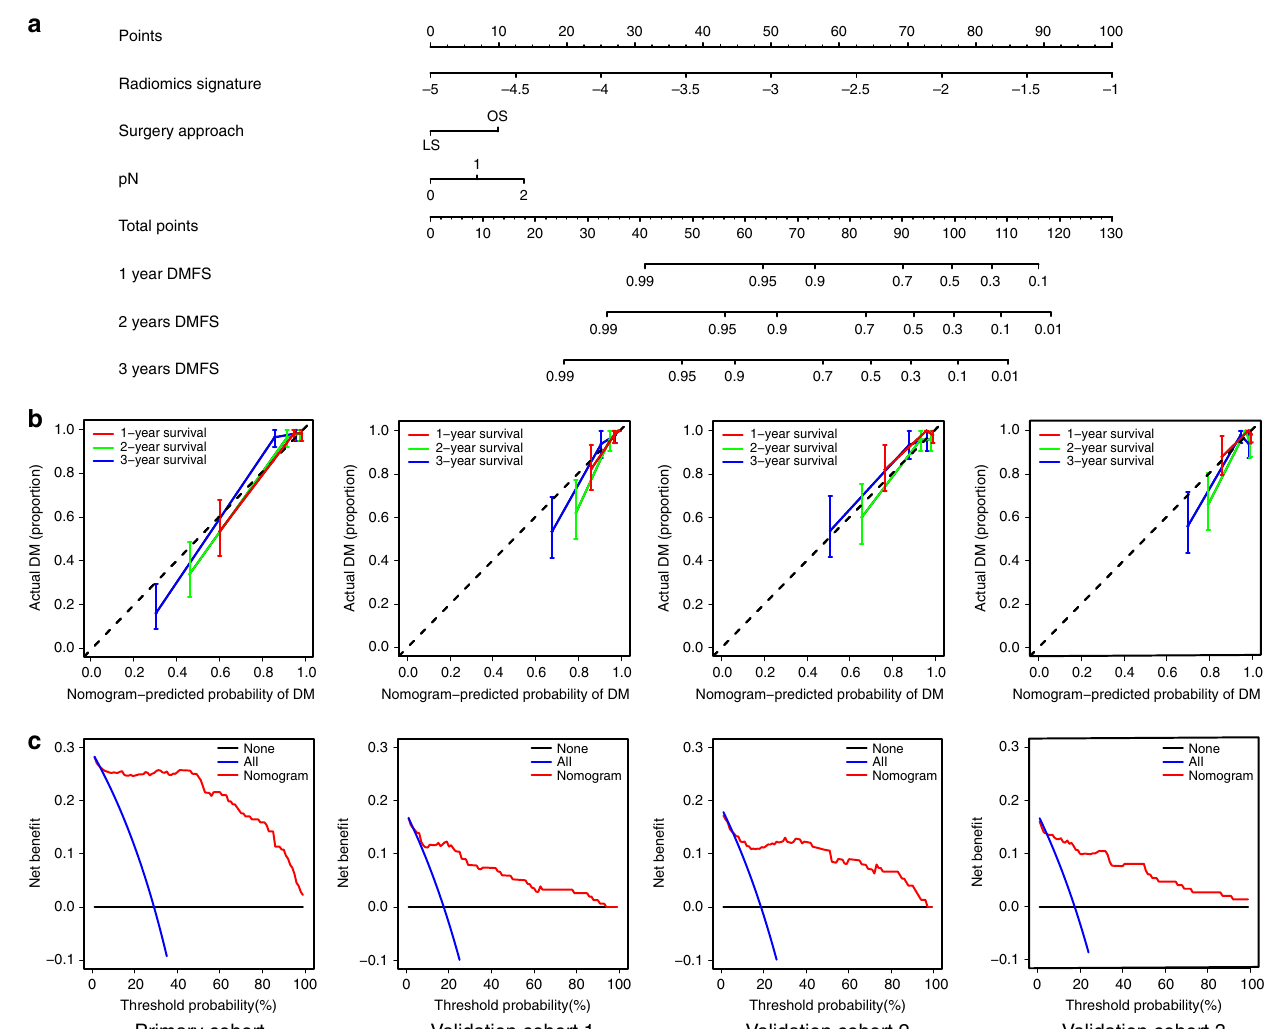
Fig. 3 Nomogram, calibration curves, and decision curves to estimate DMFS. a The radiomic nomogram for estimating DMFS. b The calibration curves for the radiomic nomogram in the primary and validation cohorts (left to right: the primary cohort with n = 176, validation cohort 1 with n = 154, validation cohort 2 with n = 150, and validation cohort 3 with n = 149). The error bars were de fi ned as s.e.m., which represent the 95% CI. c The decision curves for the nomogram in the primary and validation cohorts (left to right: the primary cohort with n = 176, validation cohort 1 with n = 154, validation cohort 2 with n = 150, and validation cohort 3 with n = 149). DMFS distant metastasis-free survival.